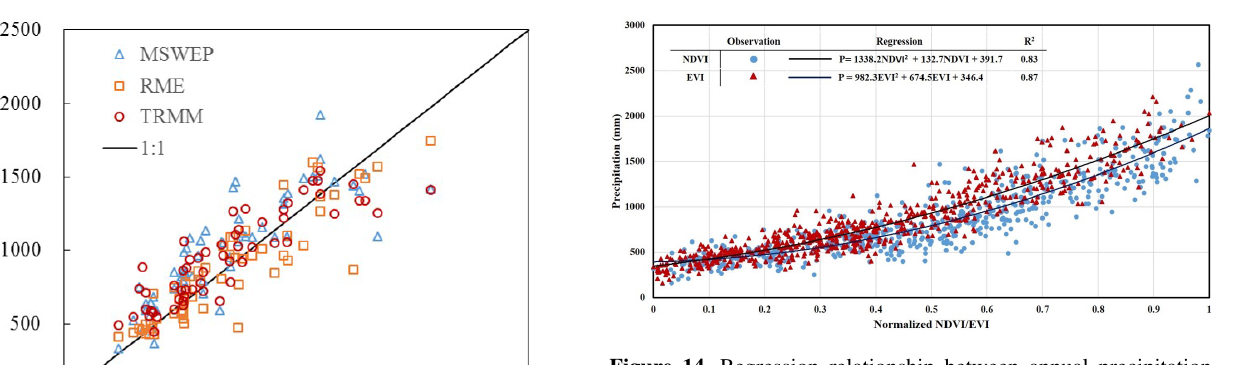
Figure 14. Regression relationship between annual precipitation and normalized